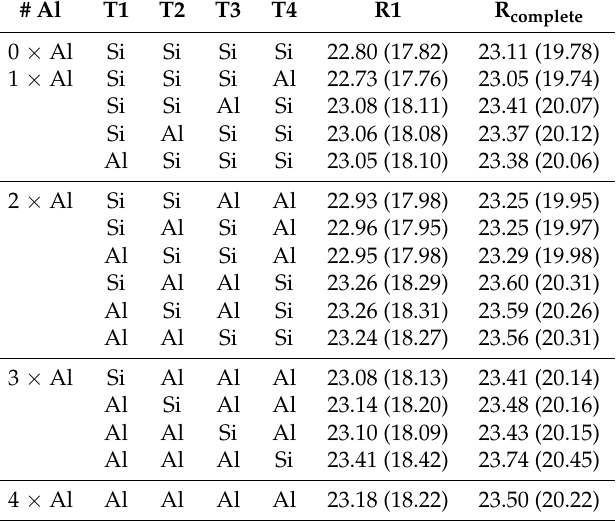
Table 1. R1 and R complete [35] values of albite for all 16 combinations of silicon and aluminum across the four T-sites of albite. The first column lists the number of T-sites modelled as aluminum, the following four columns list which T-sites were modelled as aluminum and silicon respectively. Atom coordinates and one isotropic ADP value were refined for each atom site without restraints, and until convergence was reached (zero parameter drift reported by SHELXL). Values in parentheses for strong reflections ( I > 2 σ ( I )